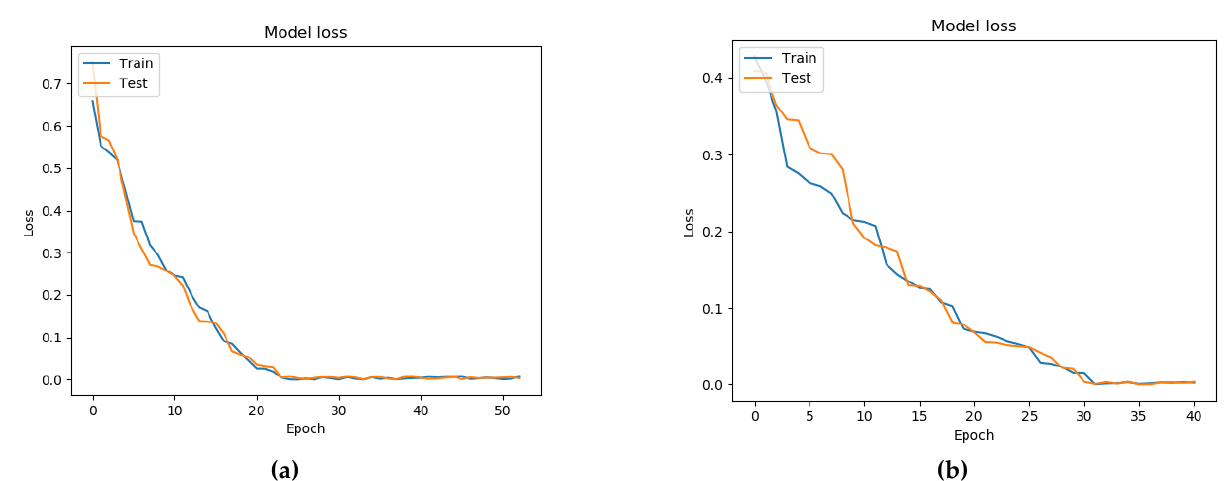
Figure 6. Graphs of the loss function when training a general neural network. ( a ) shows a graph for a general neural network built using a genetic algorithm, and ( b ) shows a graph of a general neural network that was designed using an analytical method.